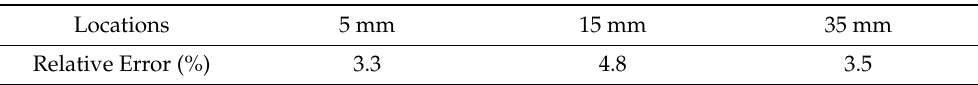
Table 1. V-velocity validation between CFD and PIV at 5 mm, 15 mm, and 35 mm downstream of the